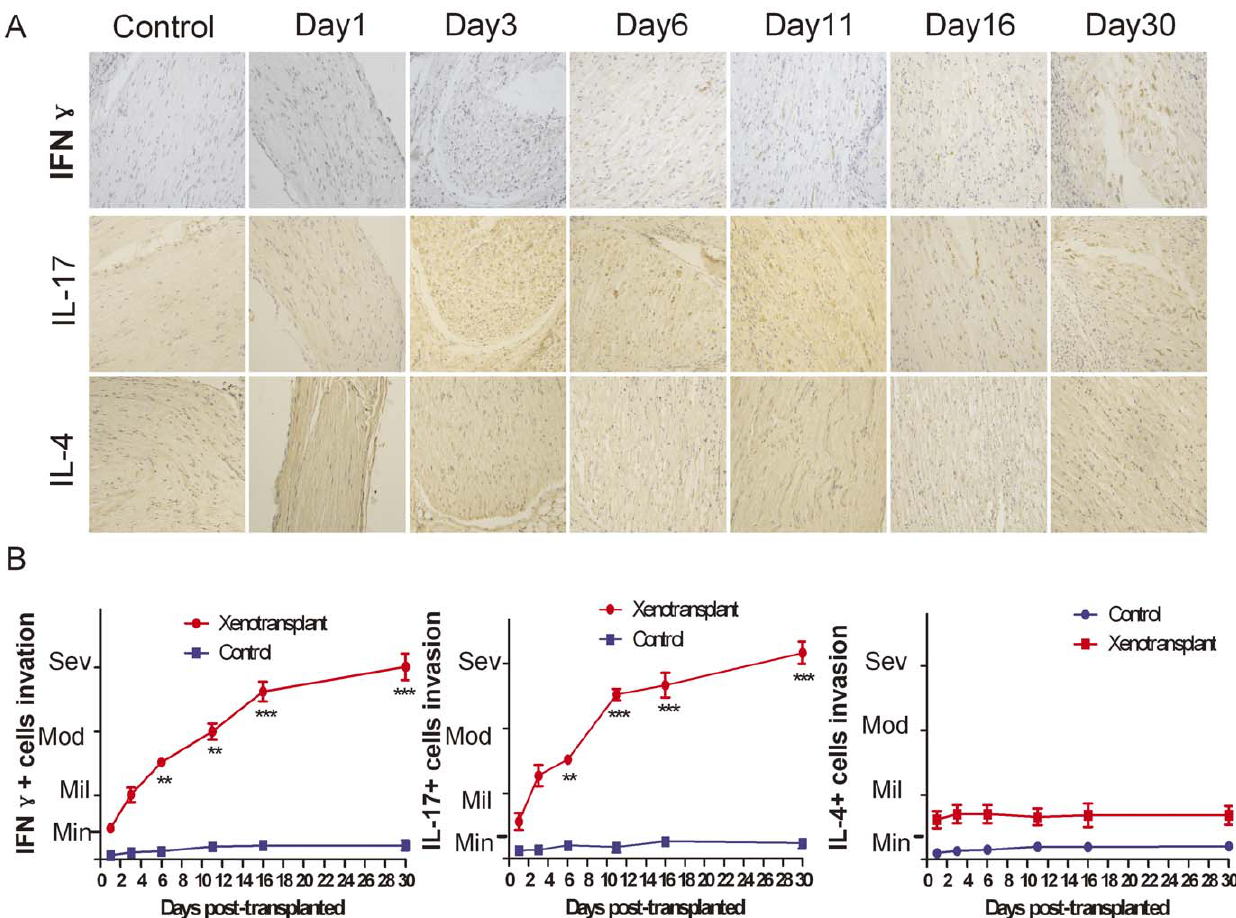
Figure 2. Immunohistochemical staining of nerve grafts. (A) Immunohistochemical staining of collected nerve grafts from sham control and xenotransplanted mice, were immunostained using anti-IFN- c , anti-IL-17, and anti-IL-4 antibodies with DAB as the chromogen with a Hematoxylin counterstain. Both antibodies demonstrated scattered immunoreactivity in the infiltrating mononuclear cells. Representative images are shown. Magnification: 200 6 . (B) IFN- c + cells and IL-17 + cells increased in xenotransplanted group from day 6 to day 30 compared to the sham controls. There is no significant difference of IL-4 + cells between the recipients and control group. *, p , 0.05; **, p , 0.01; *** p , 0.001. (We performed experiment twice, and stained 2 sections for IFN- c and IL-17 respectively of each